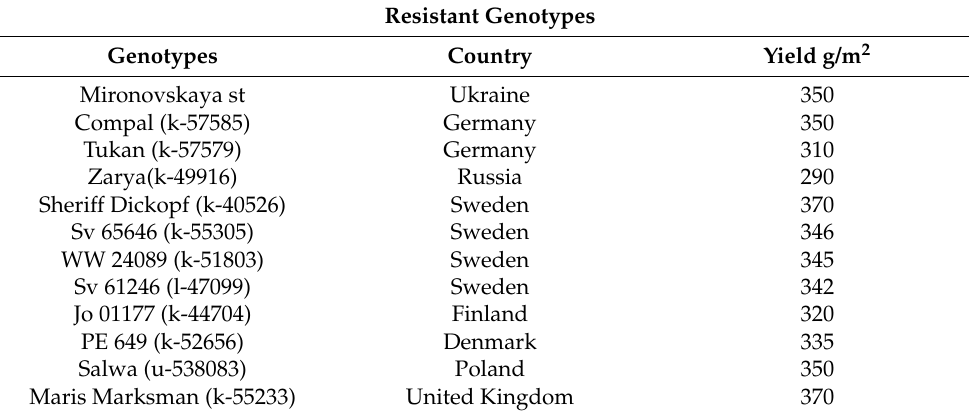
Table 5. Yield of the resistant genotypes (1997–1998).